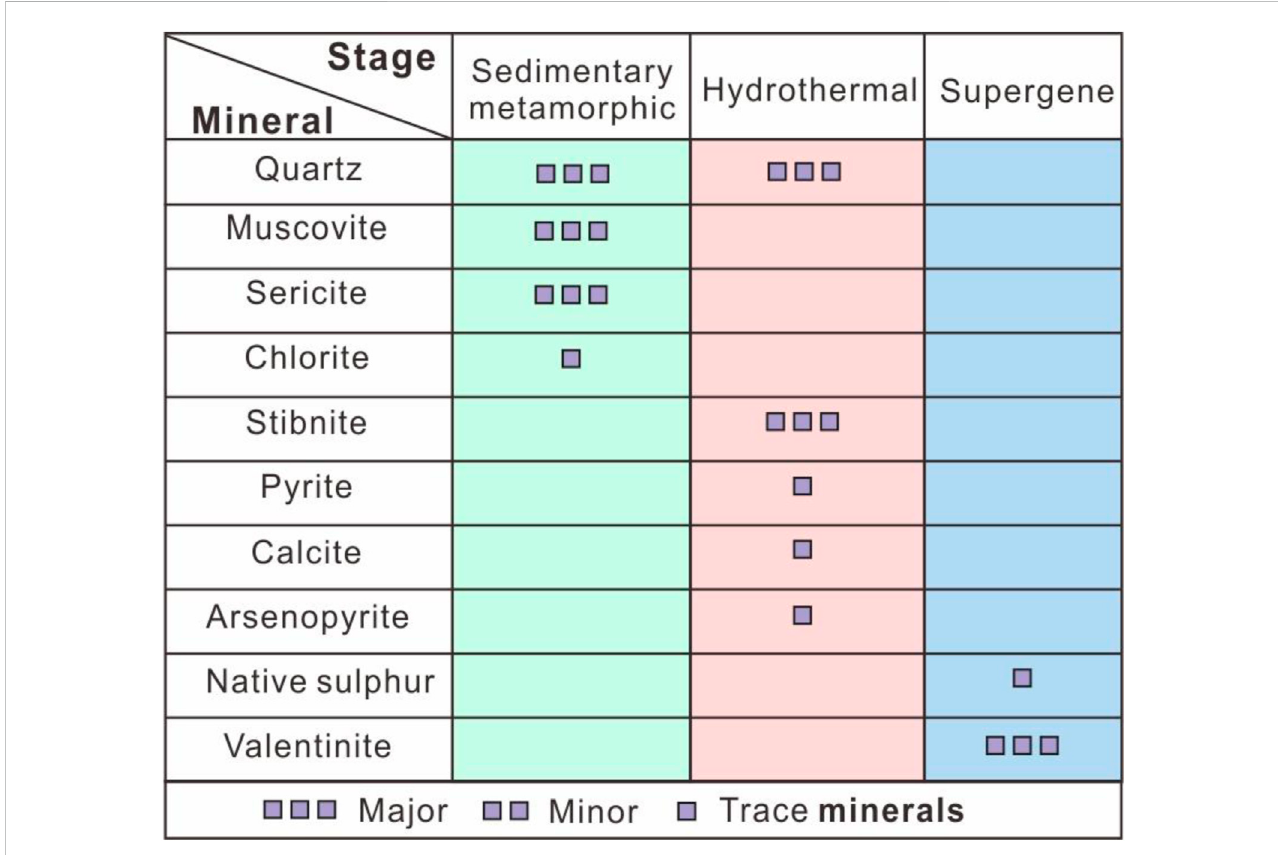
FIGURE 5 The metallogenic phase division and mineral paragenetic sequence of the Abunabu antimony deposits (Fang et al., 2006; Chen et al., 2011).